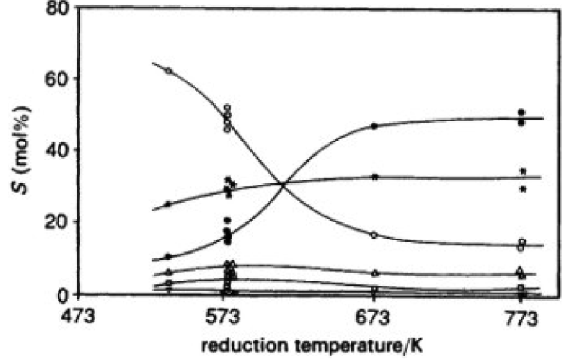
; 4 : S C 2 ; ∗ : S C 2 ; • : = − C 4